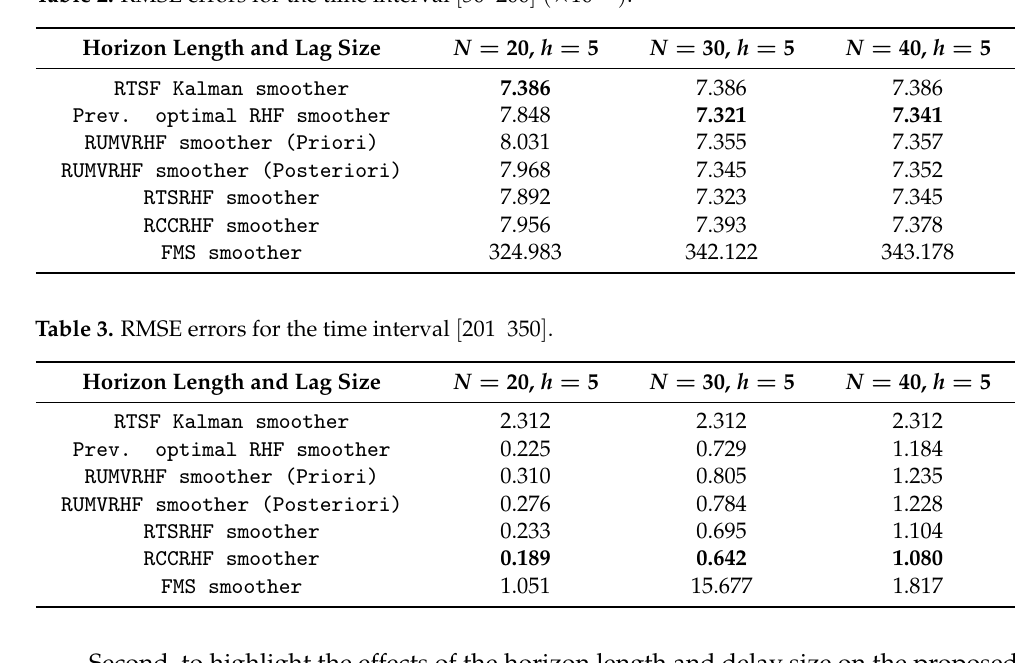
Table 2. RMSE errors for the time interval [ 50 200 ] ( × 10 − 3 ) .